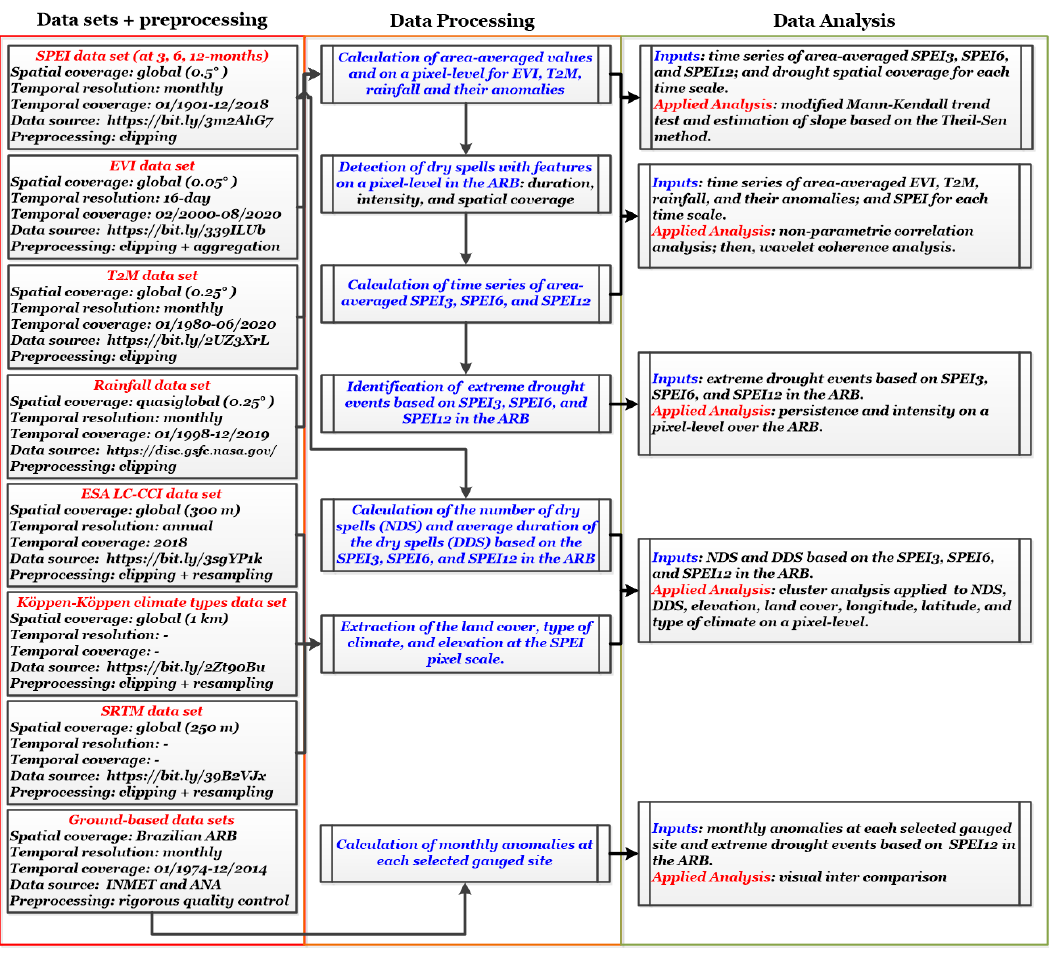
Figure 2. Simplified flowchart of the activities that were developed for this